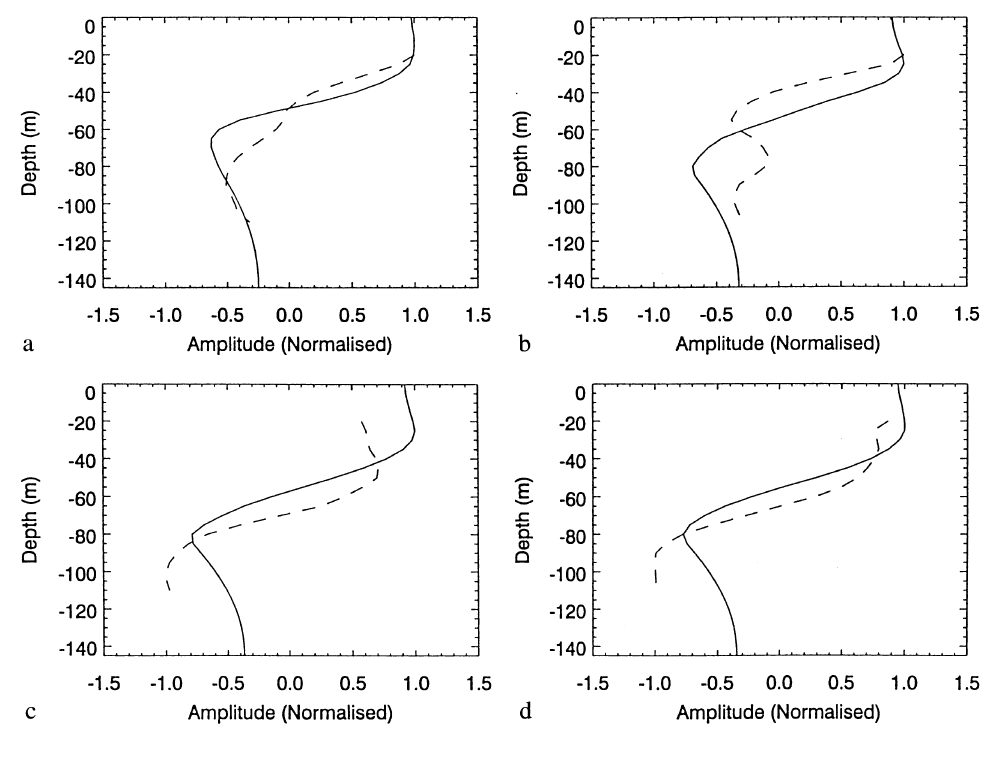
Fig. 13a–d. The first linear mode of u velocity ( solid line ) and first EOF ( dashed line ) for each of the four surveys, a–d . Both EOF and linear mode are normalised to a maximum of 1 for comparison